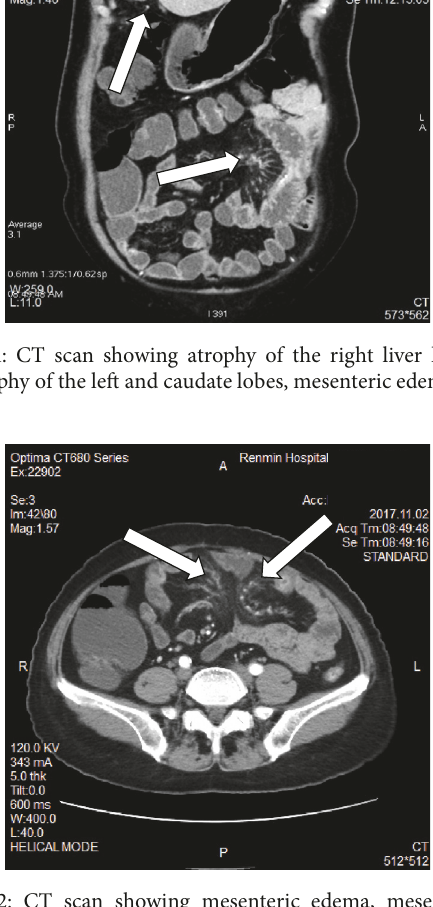
Figure 2: CT scan showing mesenteric edema, mesenteric fat